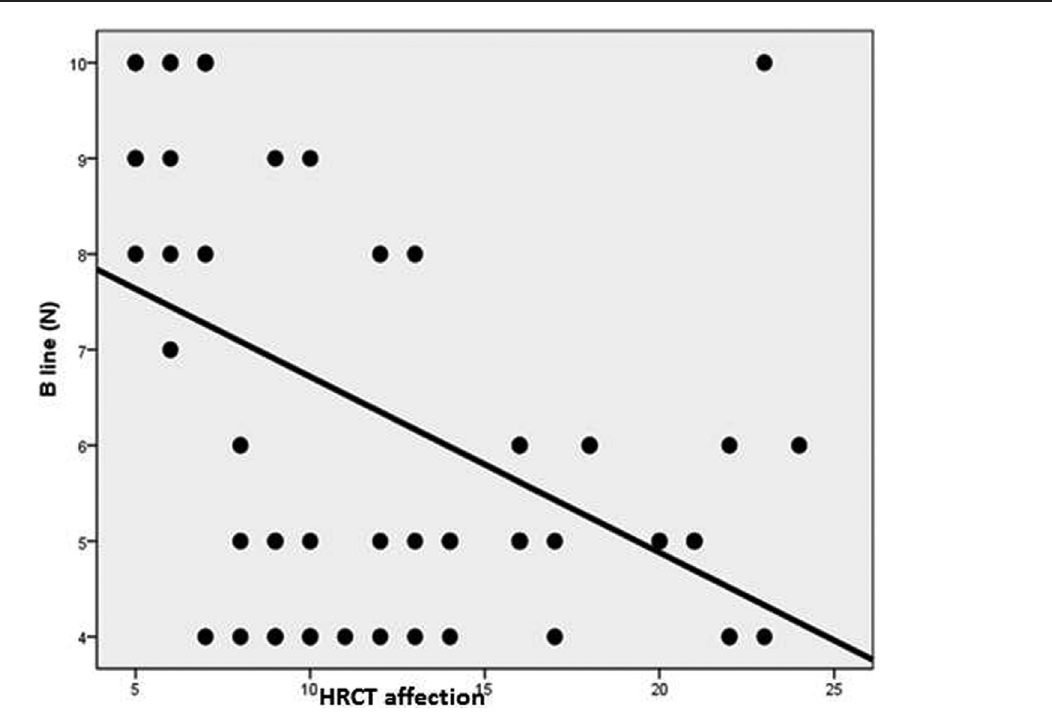
Table 8 clarifies the degree of hypoxemia among cases.